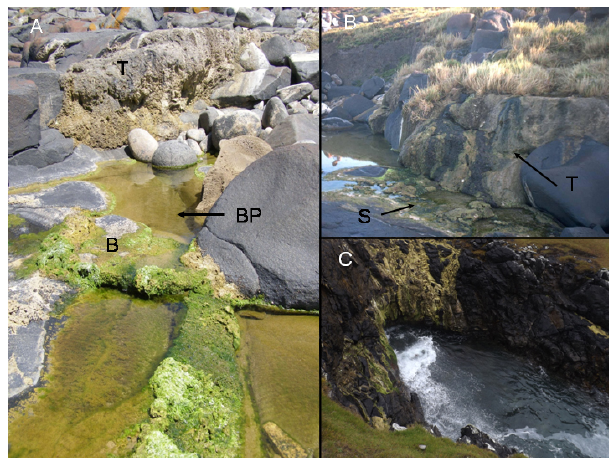
Figure 3. (a) Trapped and bound stromatolites forming on a stro- matolite apron, located on the Luskentyre Bay shore platform, Har- ris, UK. The stromatolite is growing around cobbles swept onto the apron by inflowing water. (b) Trapped and bound stromatolites developed on a cobble beach adjacent to a shore platform. Note the shell debris which has been bound into the Cape Morgan stro- matolite. (c) Dolerite boulders quarried from the shore platforms and bound by stromatolite growth. (b) and (c) are reproduced from Smith et al. (2005,